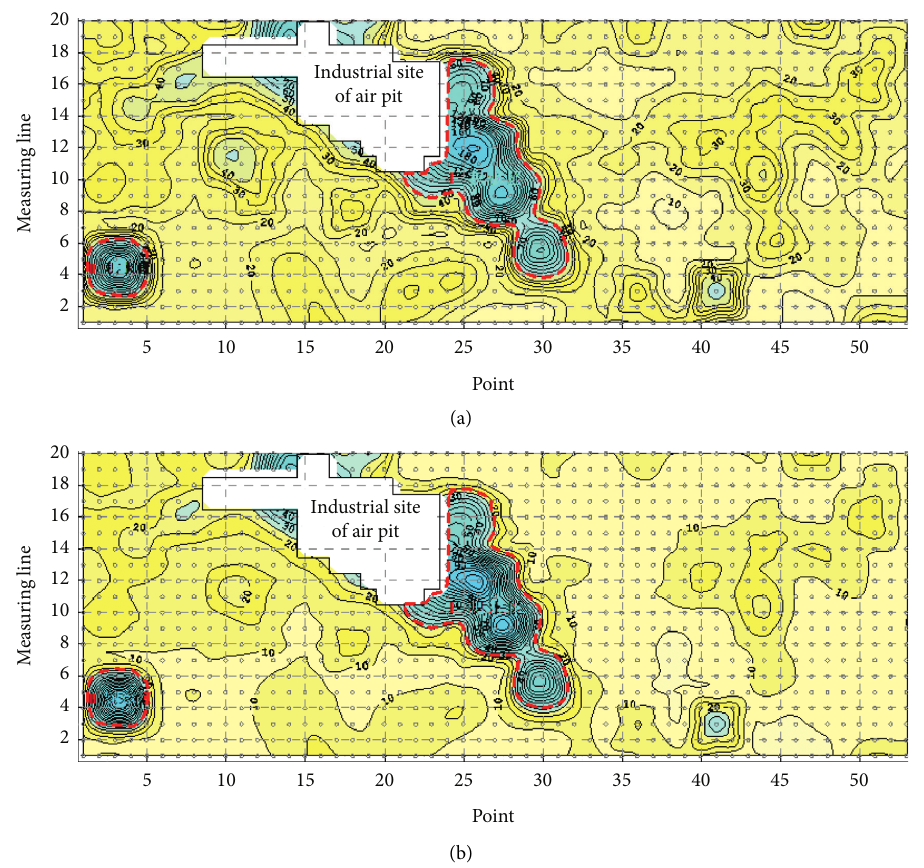
Figure 15: Plan of equal voltage value. (a) 24th measuring channels. (b) 28th measuring channels.